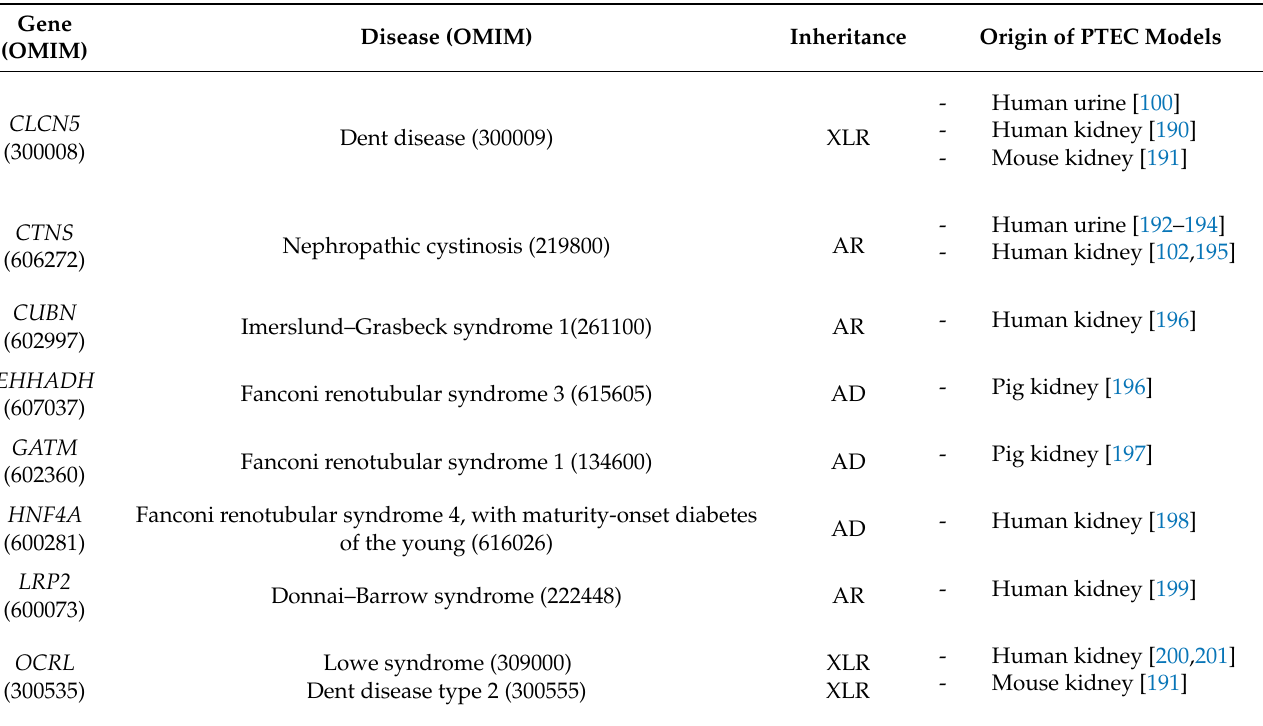
Table 2. Cell models of genetic proximal tubular